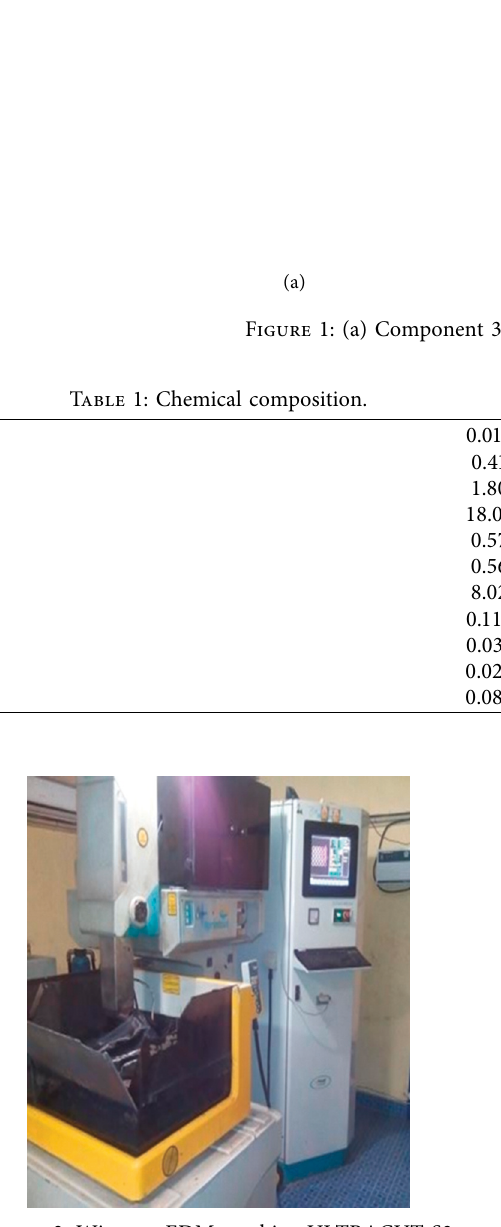
Figure 2: Wire-cut EDM machine ULTRACUT S2.